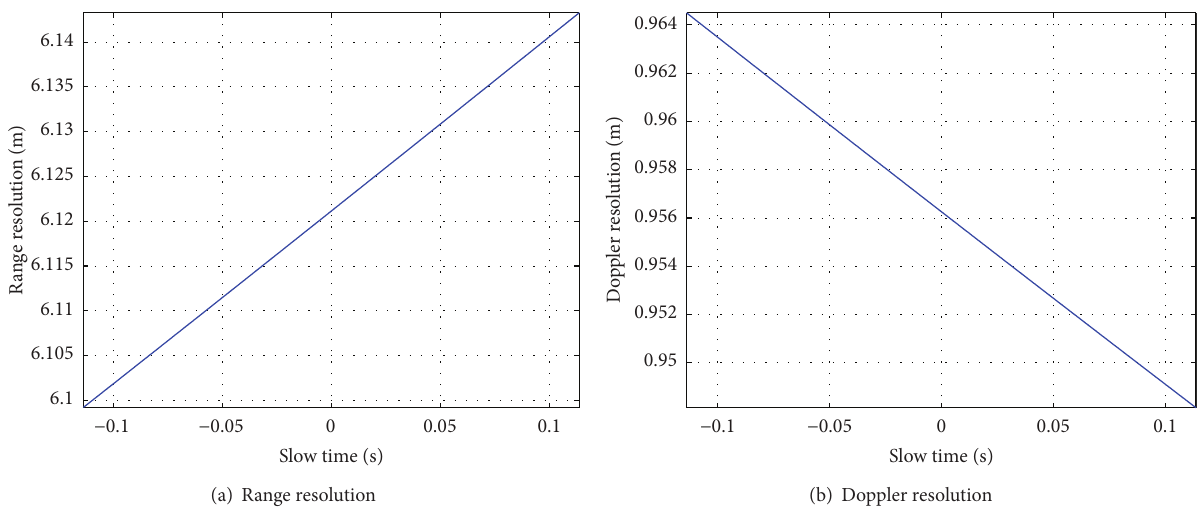
Figure 5: MBFL-SAR range resolution and Doppler resolution at different 𝑡 𝑚